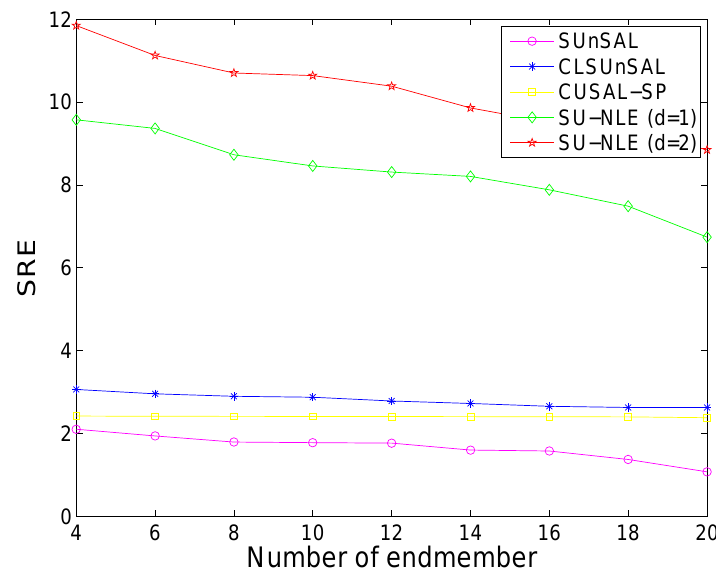
Figure 10. SREs of different methods as a function of varying number of endmember under Gaussian white noise with only mixed regions having 64 × 64 pixels and 224 bands.